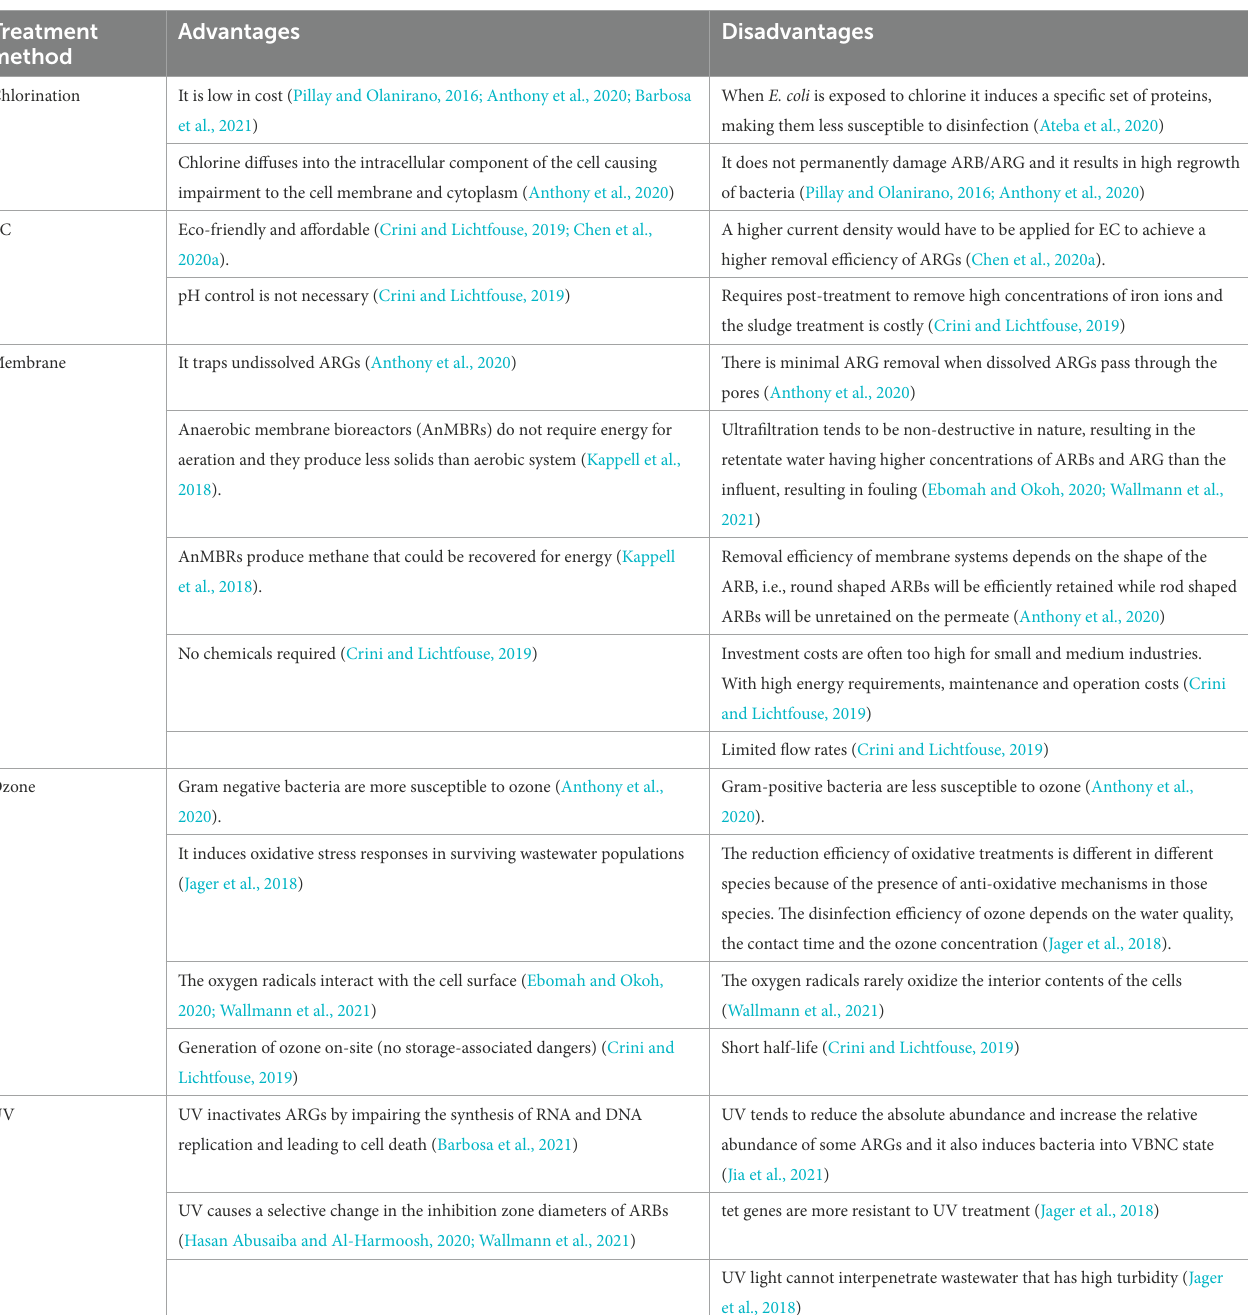
TABLE 6 Pros and cons of treatment methods. Treatment